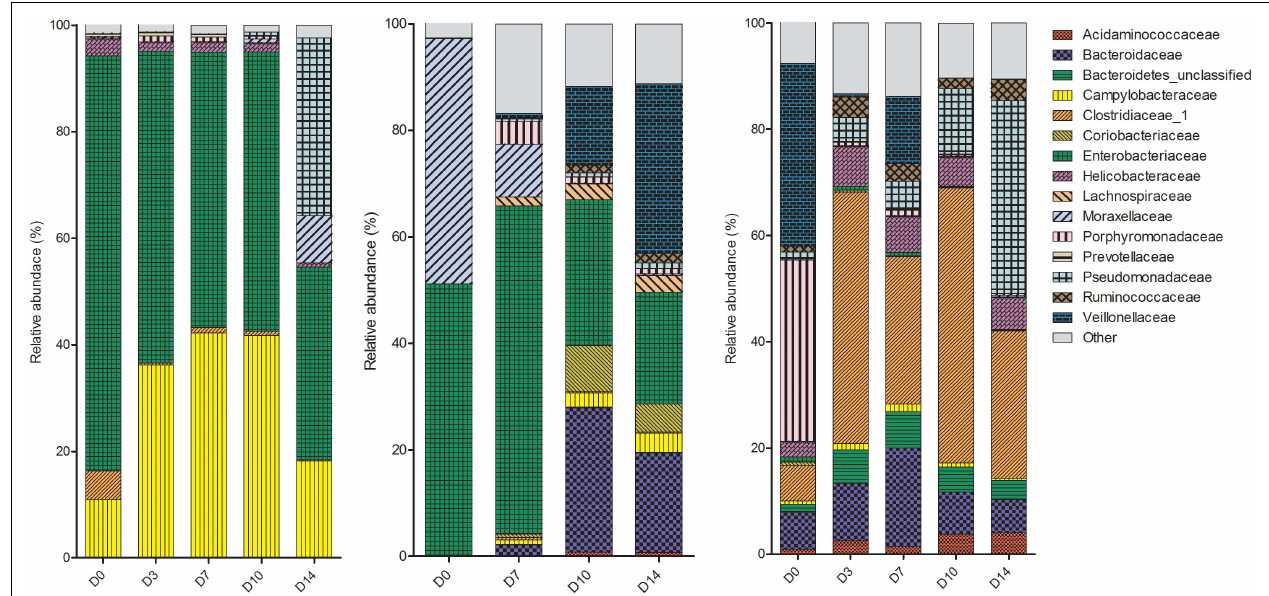
FIGURE 2 | Shifts in the relative abundance of the top 10 bacterial families in piglet rectal swabs collected from piglet 1, piglet 2, and piglet 3 (left to right). The x-axis describes the day on which the sample was collected (D0, D3, D7, D10 or D14).